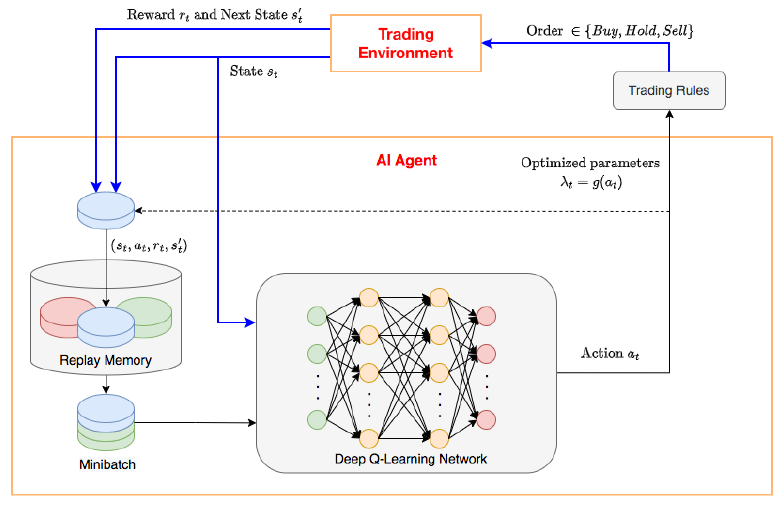
Figure 1. Illustration of the learning mechanism in trading